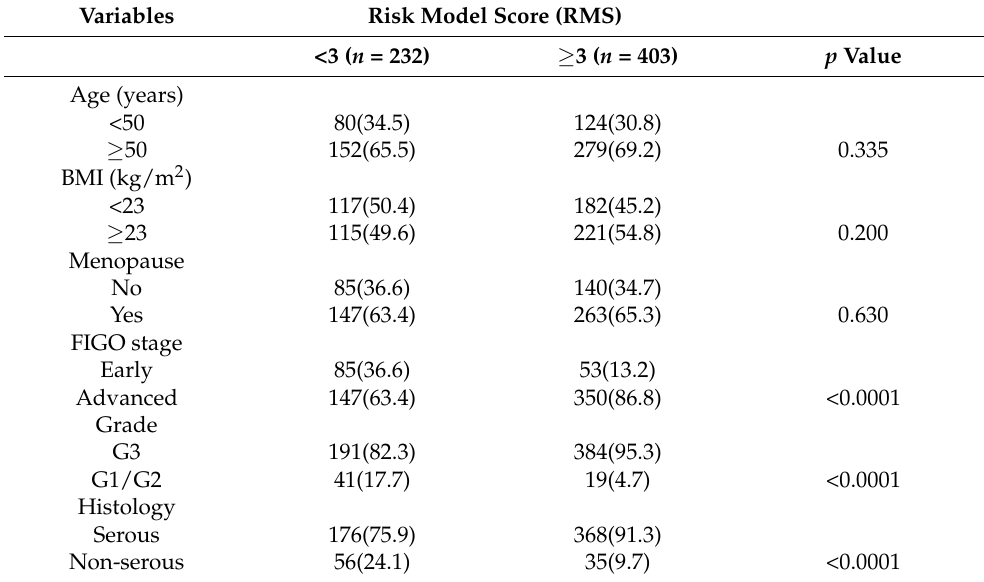
Table 2. Relationships between preoperative RMS and clinical characteristics in patients with EOC ( n =